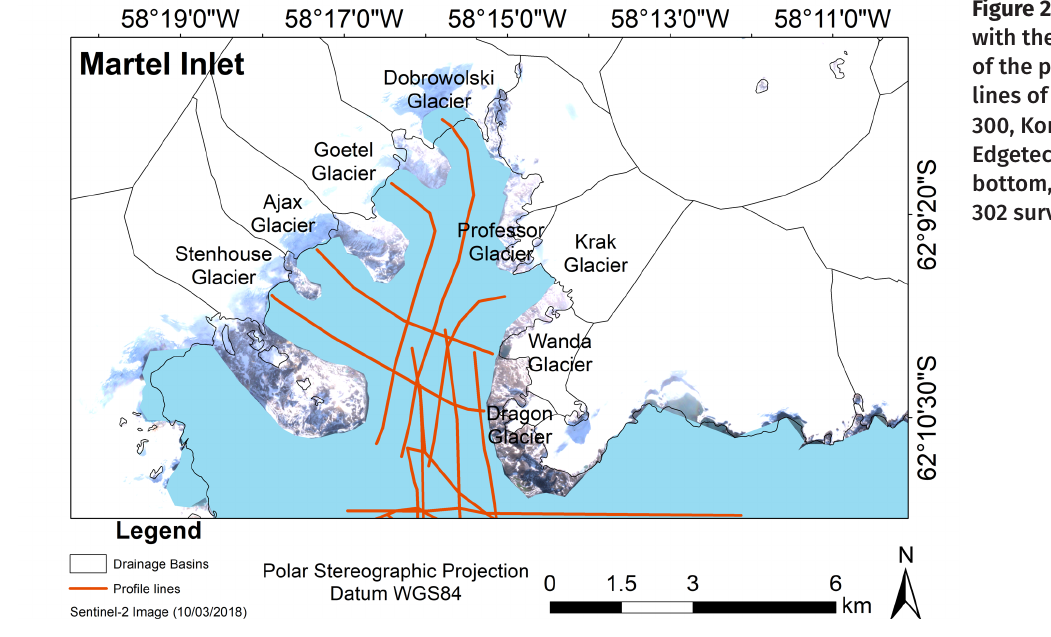
Figure 2. Track map with the locations of the profiler lines of the SBP 300, Konsberg and Edgetech 3200 sub- bottom, and Simrad 302